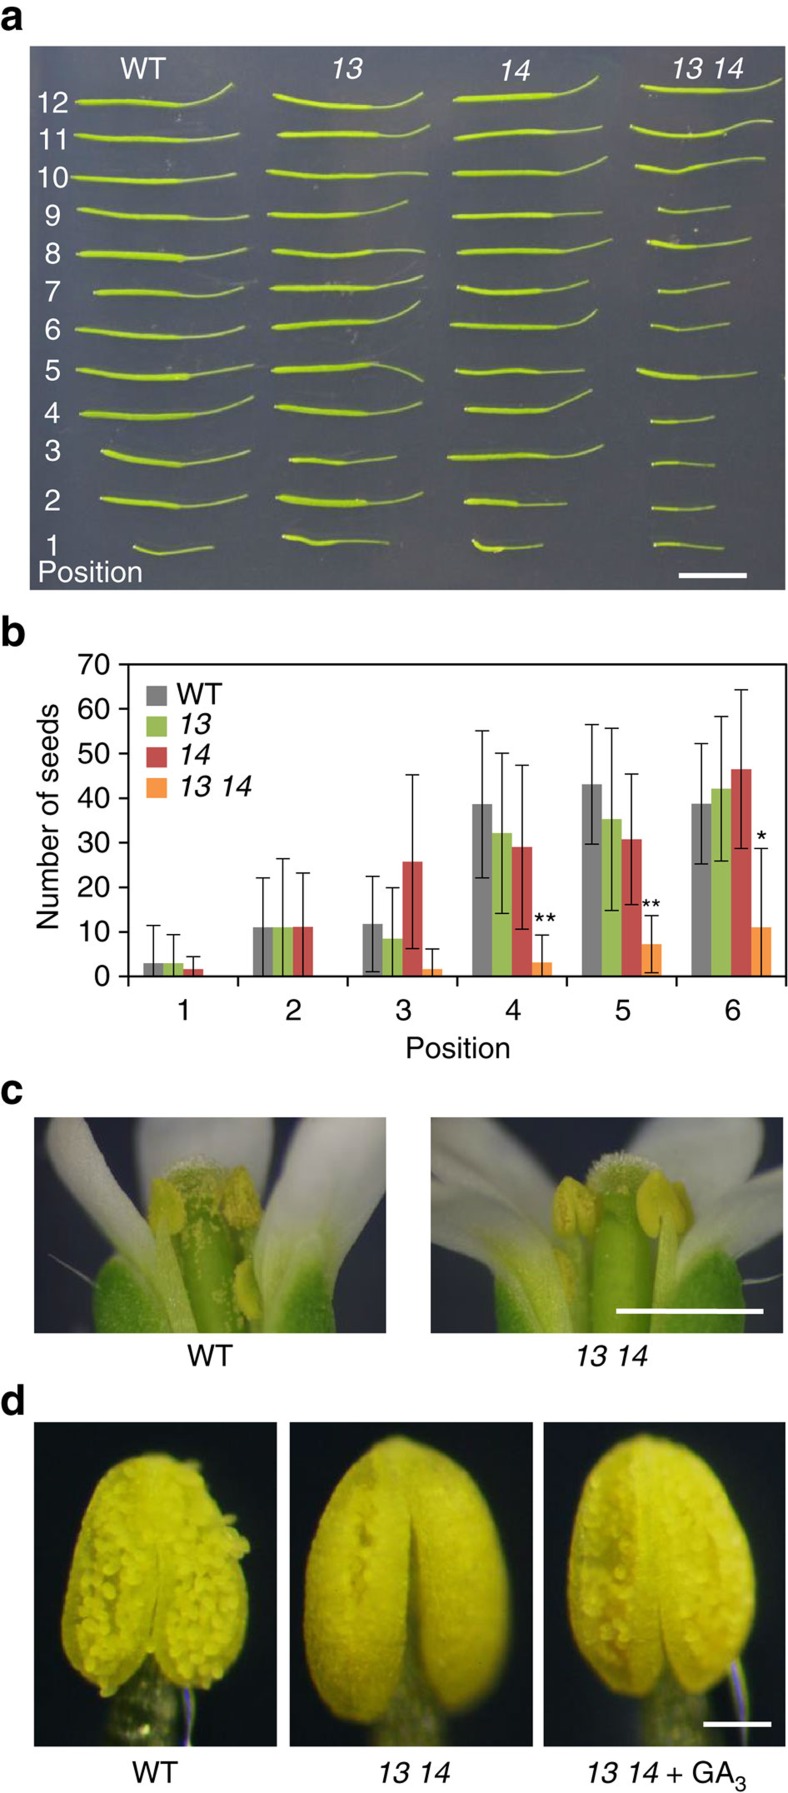
Phenotypes of sweet13 sweet14 in flowers and siliques.(a) Representative siliques from wild type (WT), sweet13 (13), sweet14 (14) and sweet13 sweet14 (13 14). Positions of the siliques from the bottom are indicated on the left side of the photo. Scale bar, 1 cm. (b) Numbers of seeds per siliques in wild type (WT), sweet13 (13), sweet14 (14) and sweet13 sweet14 (13 14). Averages of eight siliques are shown with standard deviations. The seed number of siliques at different positions varied significantly; *P<0.05, **P<0.001; Tukey–Kramer test. (c) Representative photos of flowers and anthers of wild type (WT) and sweet13 sweet14. Scale bar, 1 mm. (d) Restoration of the sweet13 sweet14 phenotype by GA3 treatment. Excised flower buds of sweet13 sweet14 were incubated with water (13 14) or 100 μM GA3 (13 14+GA3) and anthers were observed after 1 day. Wild type flower buds incubated with water were also observed for comparison (WT). Scale bar, 0.1 mm.